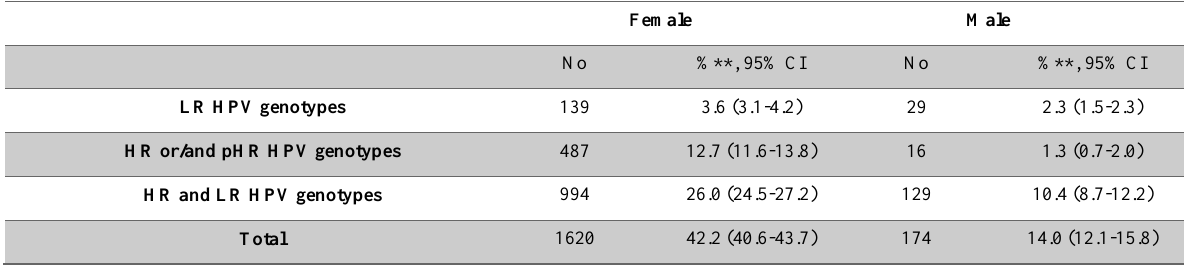
Figure2. The frequency of HPV infection according to the age in the studied males and females Table 4. The prevalence of HPV genotypes in the mixed infections*